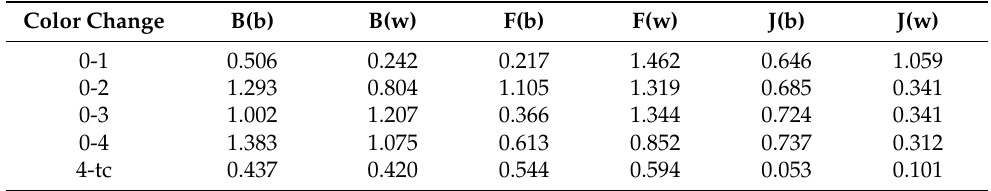
Table 4. Color changes of the materials, on black (b) and white (w) backgrounds, related to each stage of immersion and during thermocycling.